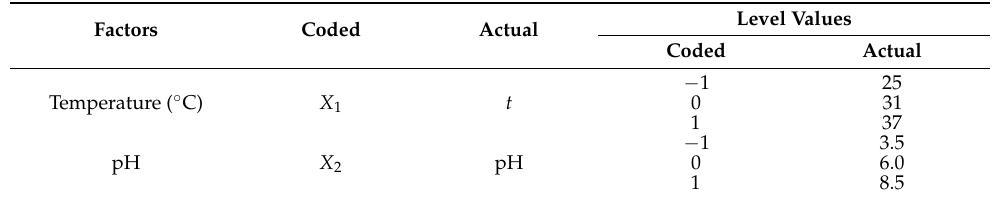
Table 1. Factors and levels in full three-level factorial design for swelling process of p(NIPAM-co-AA)